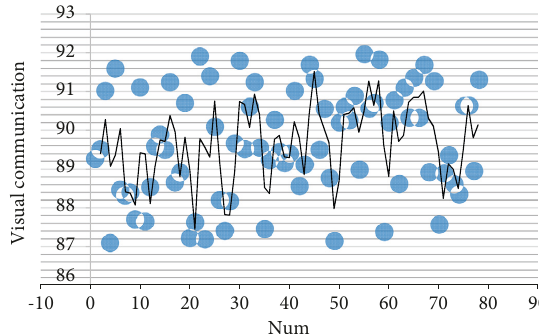
Figure 9: Visual communication effect of the 3D image visual communication system for automatic reconstruction of digital